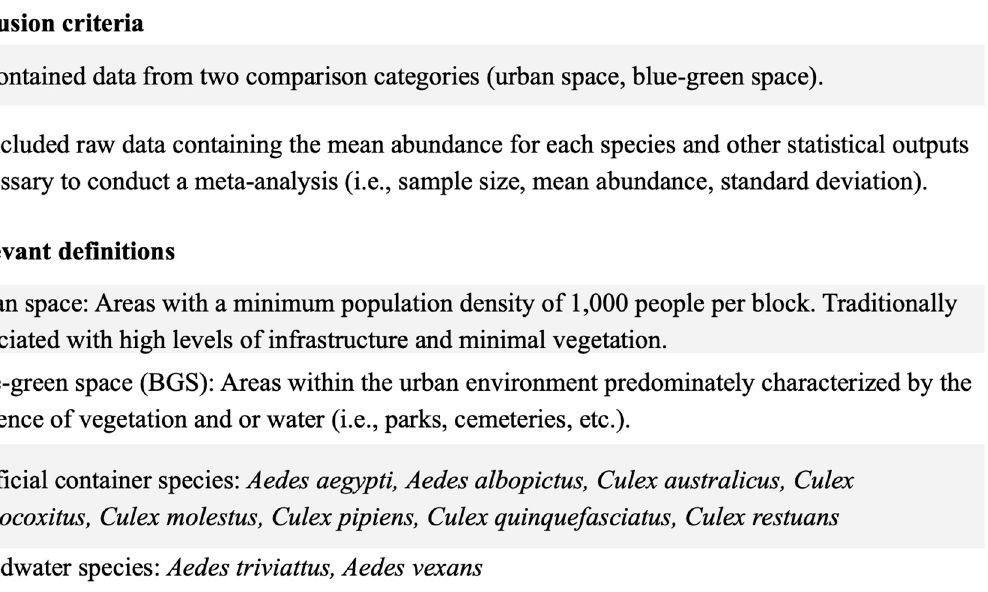
Figure 1. Inclusion criteria and relevant definitions.